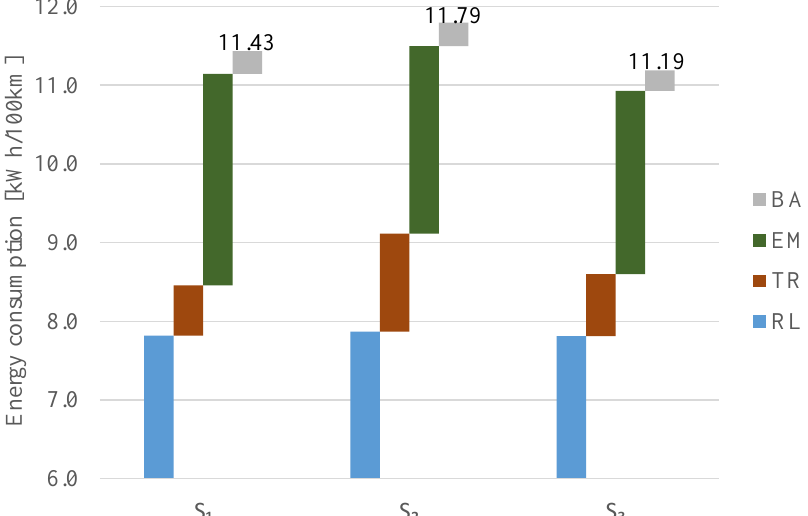
Figure 14. Comparison of energy consumption between S 1 (with a total vehicle mass of 1670 kg), S 2 (with a total vehicle mass of 1700 kg) and S 3 (with a total vehicle mass of 1666 kg) on the WLTC, where RL represents road load. The transmission (TR) losses include the ELOP power dissipation, which is zero in S 1 . The EM power losses include the effect of the DC-AC